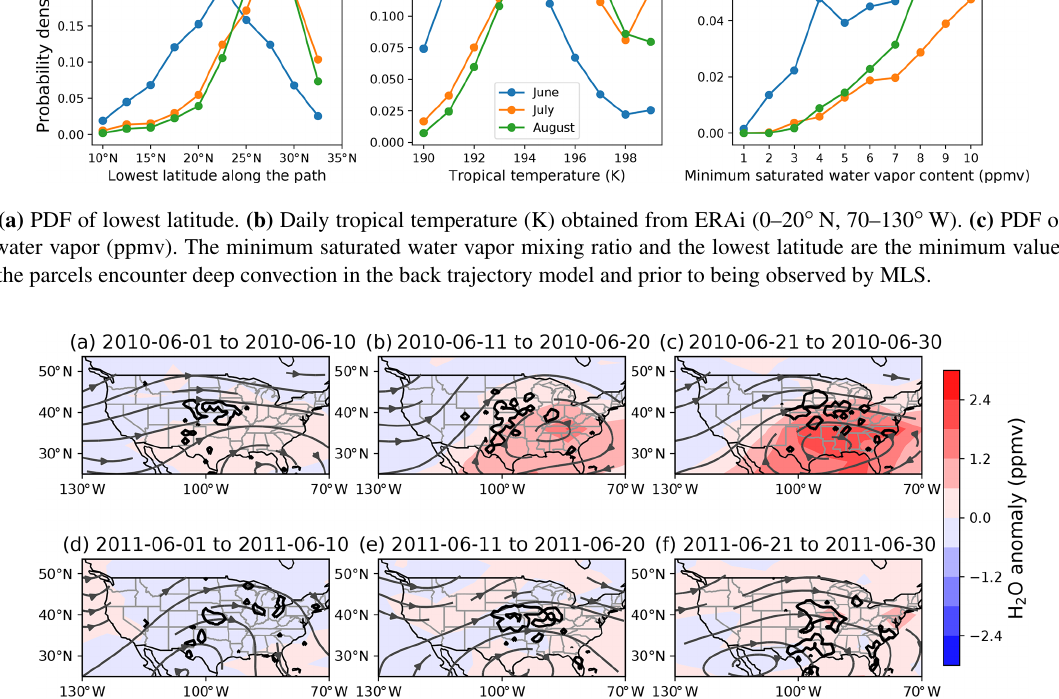
Figure 5. The 10d average water vapor anomaly (ppmv) at 100hPa (after removing the zonal mean) during (a–c) June 2010 and (d– f) June 2011. Thick black contours are the 10 − 5 contours of GridRad deep convection, and stream lines are horizontal velocity at 100hPa obtained from ERAi averaged over the same